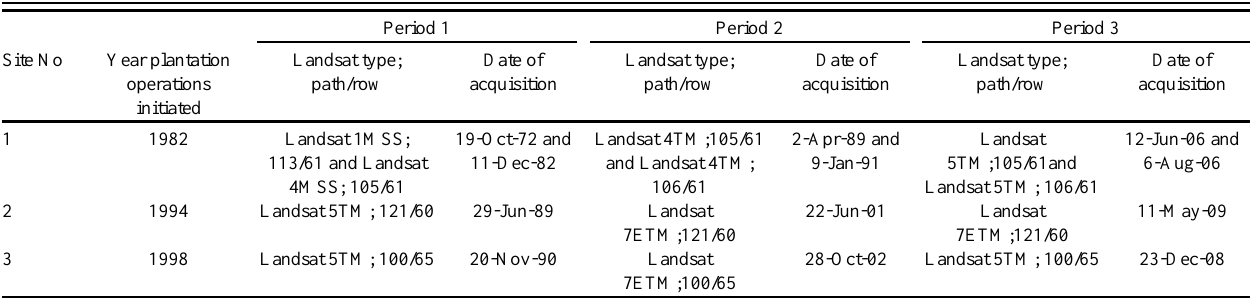
Table 4 . Landsat images used for spatial analysis.